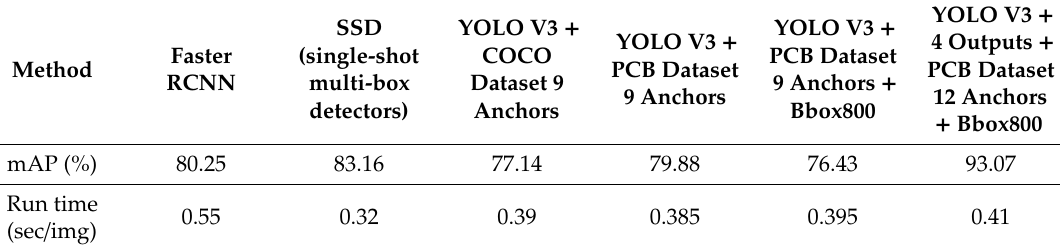
Table 5. mAP and detection speed for some object detection methods on the PCB